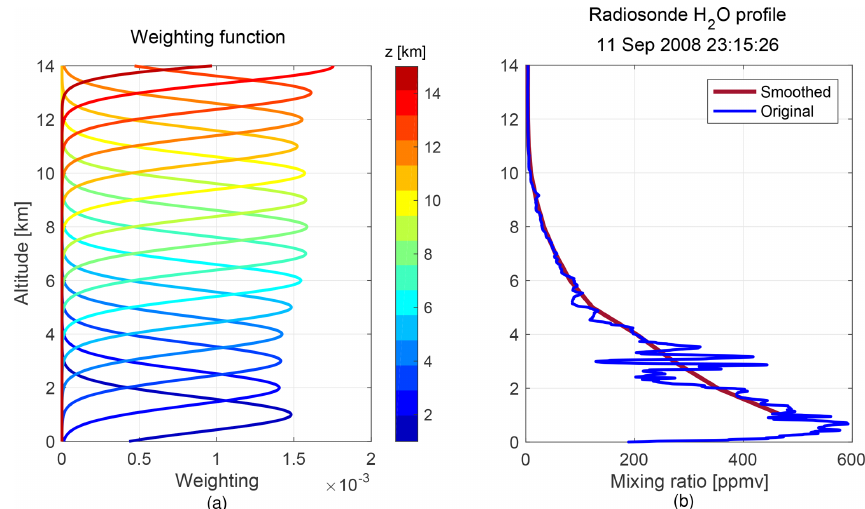
Figure 4. (a) shows an example of weighting functions used to smooth the radiosonde profiles to ACE-FTS vertical resolution. (b) shows the corresponding radiosonde profile, both measured (blue line) and after smoothing (maroon line), with the weighting function shown in (a) .